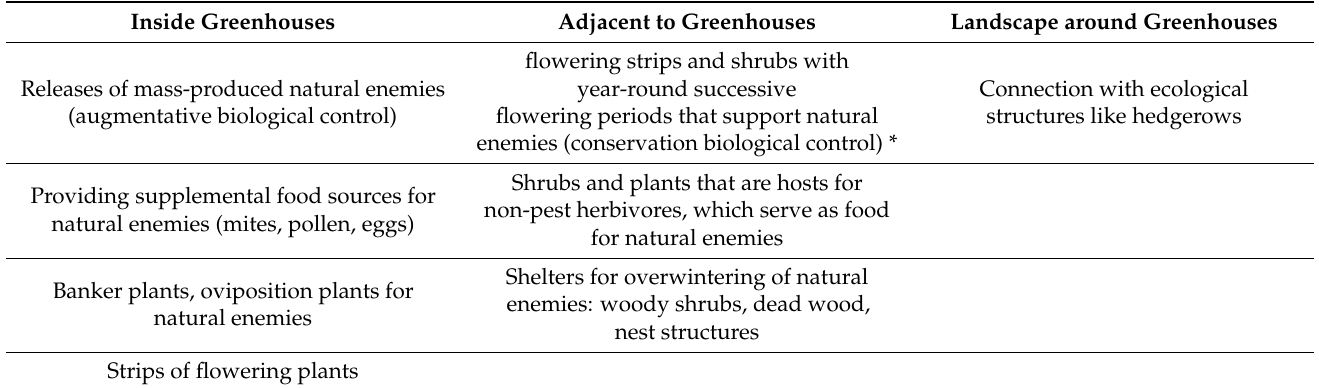
Table 2. Measures inside and outside greenhouses to support biological pest control through functional biodiversity.